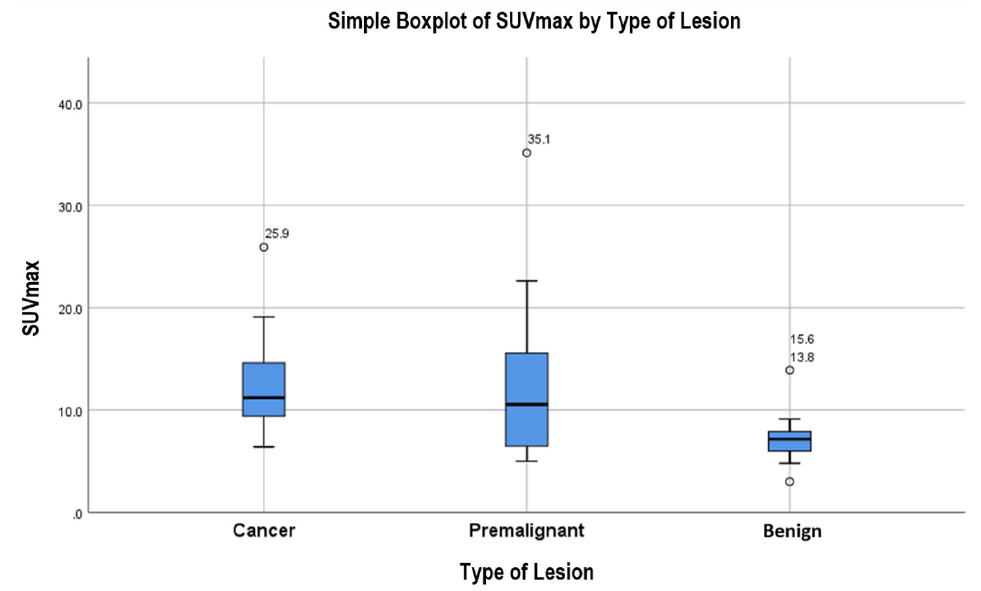
Figure 4. Simple boxplot of SUVmax comparison between benign, pre-malignant, and malignant lesions.